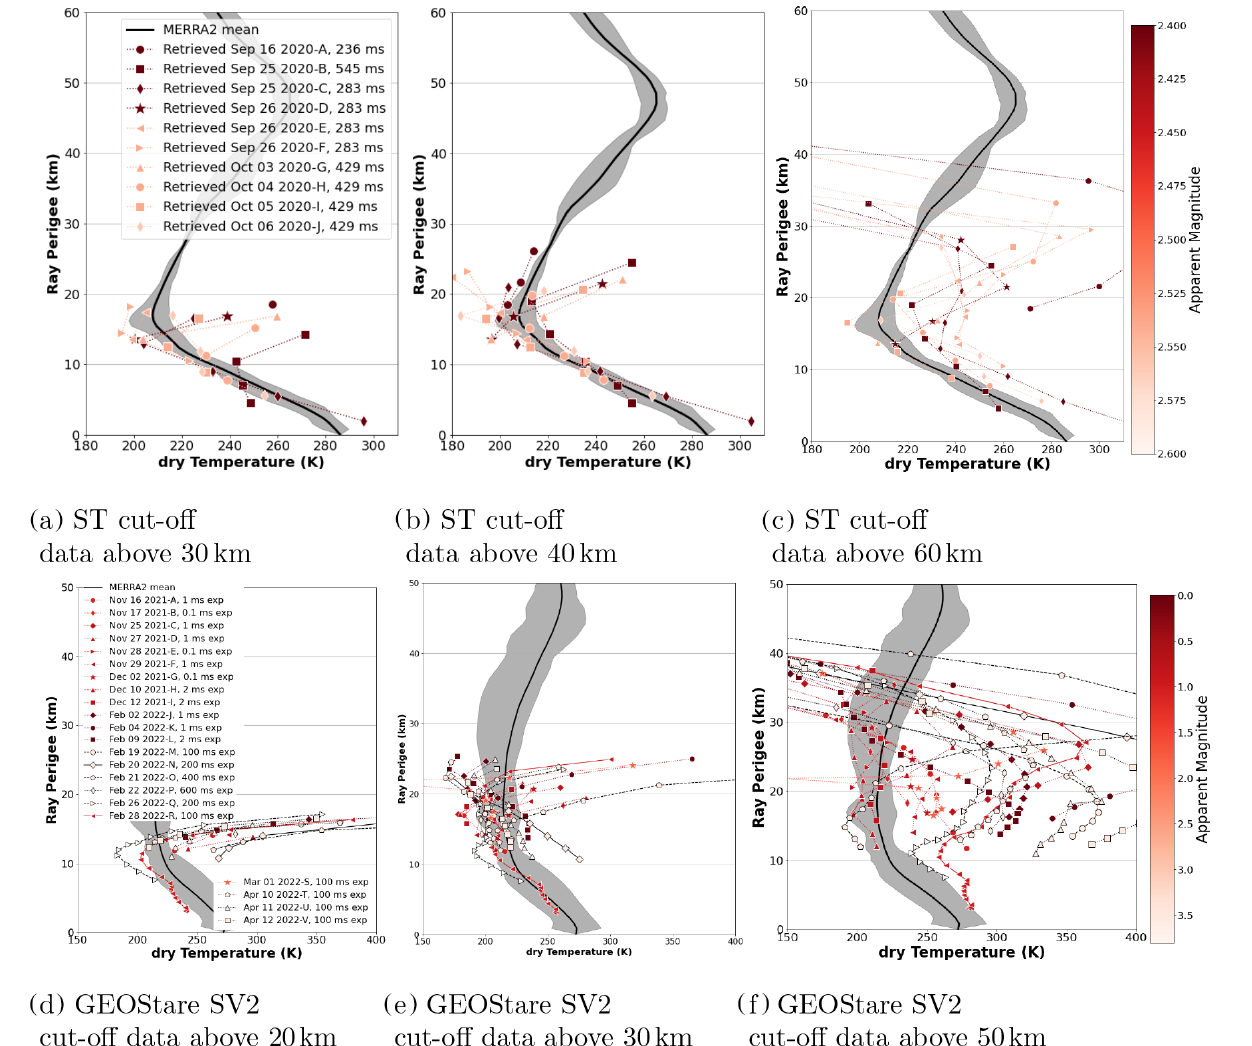
Figure 5. Retrieved temperature profiles from ST and GEOStare SV2 observations. The observation marker shape and color correspond to Figs. 3 and 4 according to the captured star’s apparent magnitude shown in the color bars on the right for each measurement dataset. The mean temperature profile predicted by MERRA2 is shown as the black line with the range across the varying measurement locations and dates shown in the gray shaded